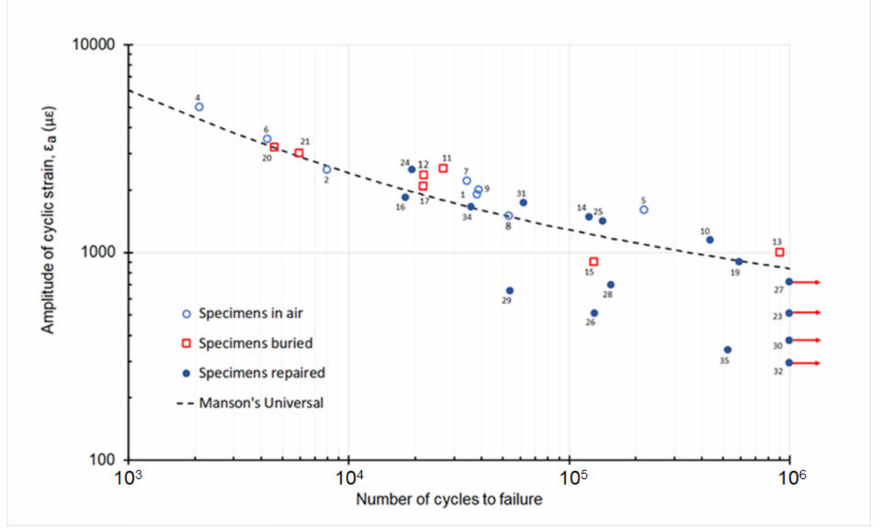
Figure 14. Comparison between buried and repaired tests results and the in-air specimens tested by [11].